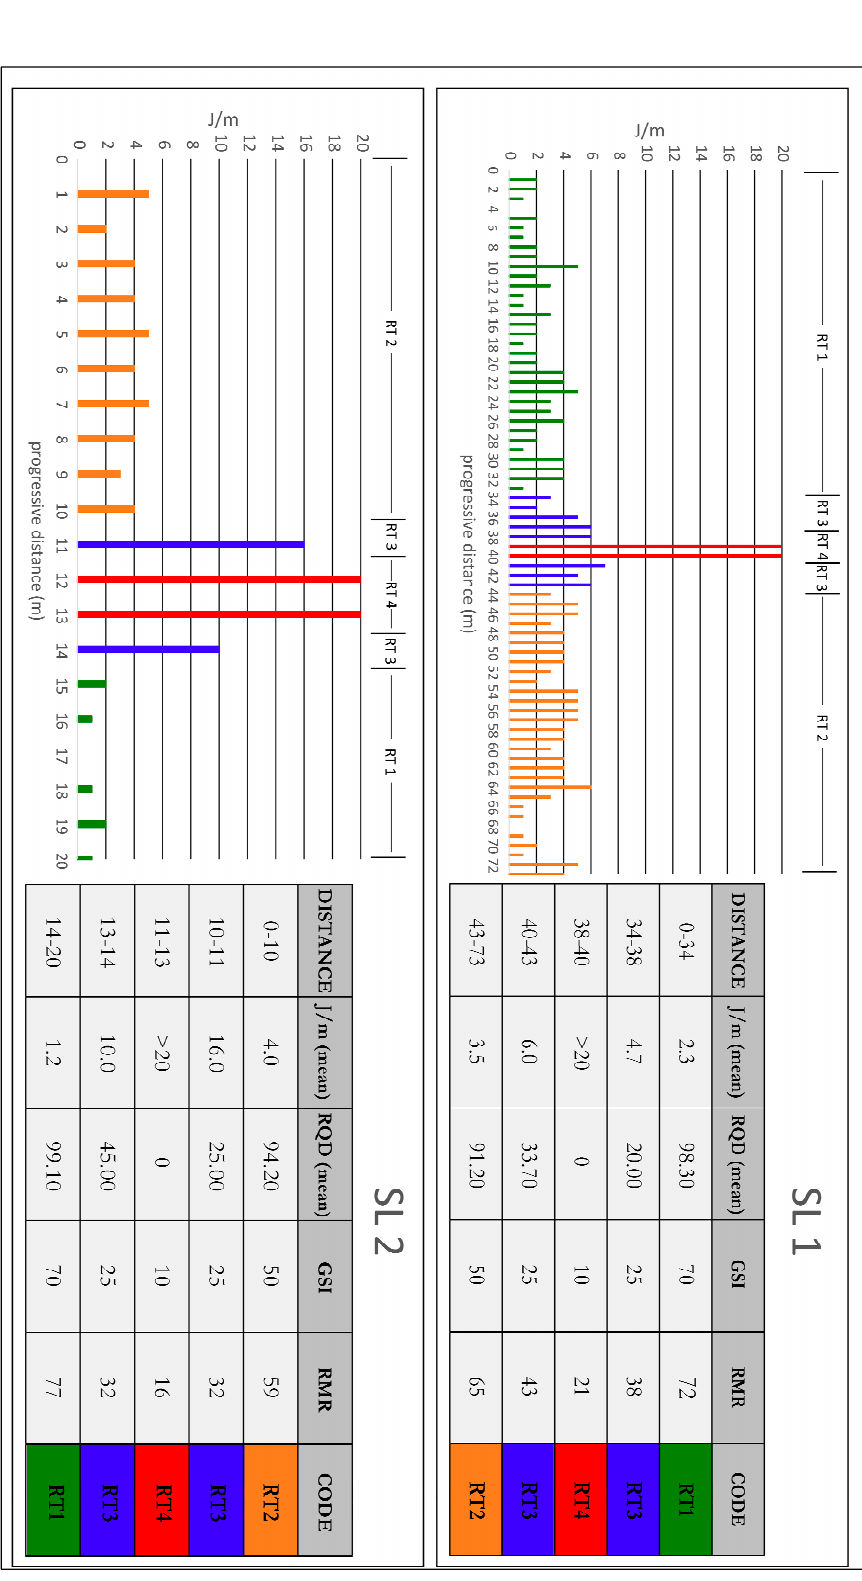
Figure 5. Scanlines results on the selected benches: rock types (in colours) and geomechanical indexes are referred to faults and the surroundings.